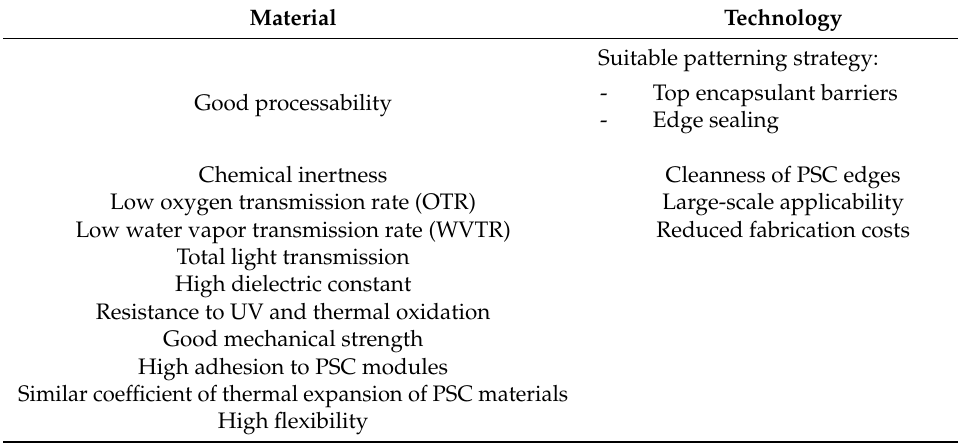
Table 3. Requirements for encapsulant material and technological approaches for sustainable and large-scale encapsulation